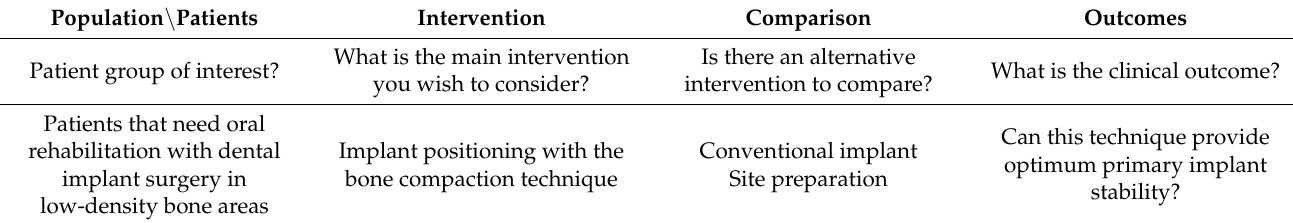
Table 1. PICO (population, intervention, comparison, outcome) questions explication. Population \ Patients Intervention Comparison Outcomes What is the main intervention Is there an alternative What is the clinical outcome? Patient group of interest? you wish to consider? intervention to compare? Patients that need oral rehabilitation with dental bone compaction implant surgery in low-density bone areas